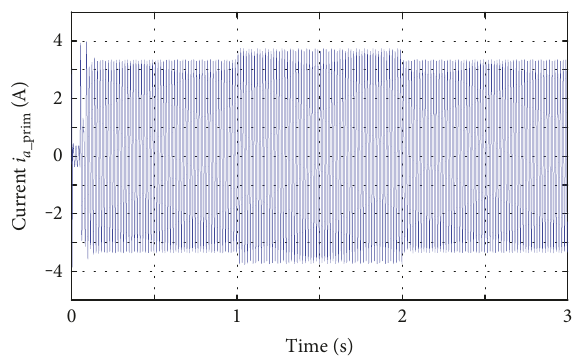
Figure 10: Primary current i